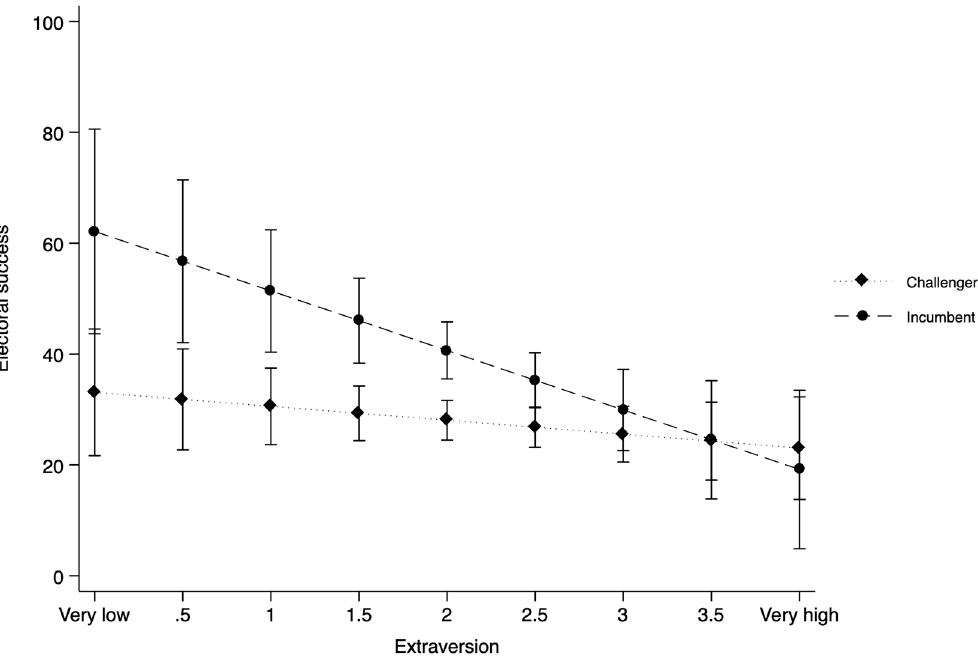
Figure 3. Electoral success by incumbency status * Extraversion; marginal effects.